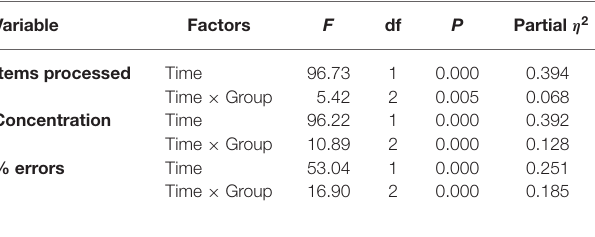
TABLE 2 | Significant ANCOVA results on attentional test scores. Variable Factors Items